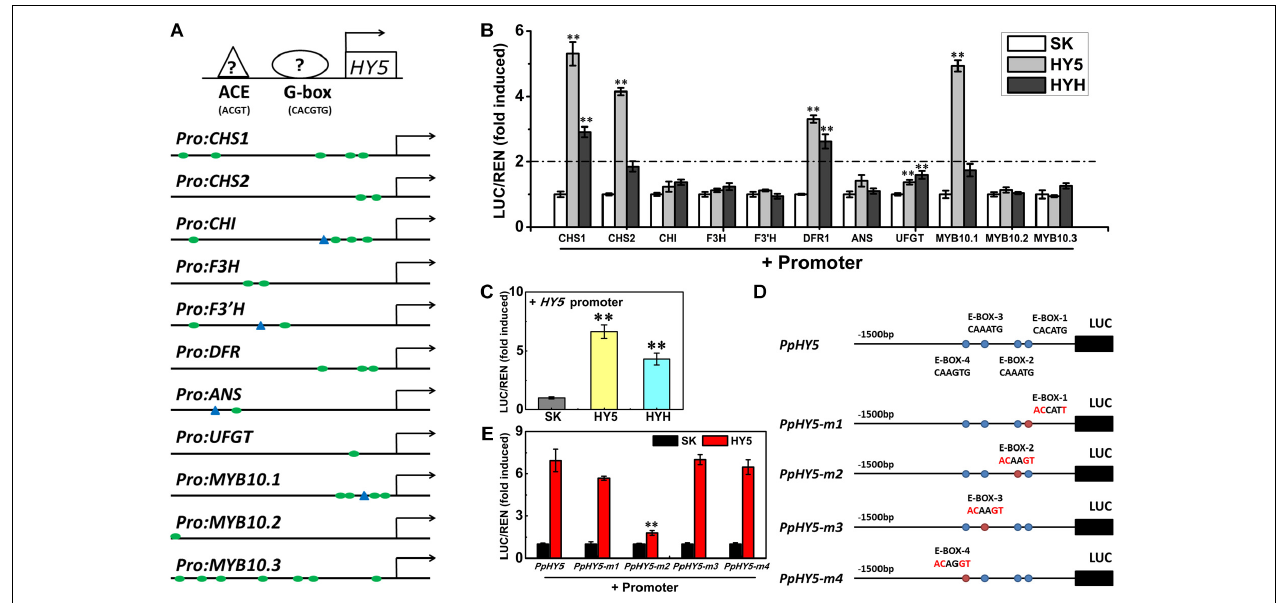
FIGURE 7 | Activation/self-activation of anthocyanin biosynthesis related genes by PpHY5 or PpHYH. (A) Upstream sequences (1500 bp) of anthocyanin biosynthesis related genes with G-box and ACGT containing element (ACE) motifs presented as green circles and blue triangles in the promoters, respectively. (B) Effects of PpHY5 or PpHYH on the promoter activity of anthocyanin biosynthesis related genes in dual-luciferase assays. (C) Effects of PpHY5 or PpHYH on the promoter activity of PpHY5 in dual-luciferase assays. (D,E) Schematic diagrams of motif mutations for the PpHY5 promoter (D) and effects of PpHY5 on the activity of original and mutated promoters in dual-luciferase assays (E) . The ratio of LUC/REN of the empty vector (SK) plus promoter was used as the calibrator (set as 1). LUC: firefly luciferase; REN: renilla luciferase; green circles: G-box; blue triangles: ACE motif; blue circles: E-box; red circles: mutated E-box. Data were presented as means ( ± SE) from six independent biological replicates and Student’s t -test was used for statistical analyses compared with corresponding control. Asterisks ( ∗∗ ) indicated a highly significant difference at P <